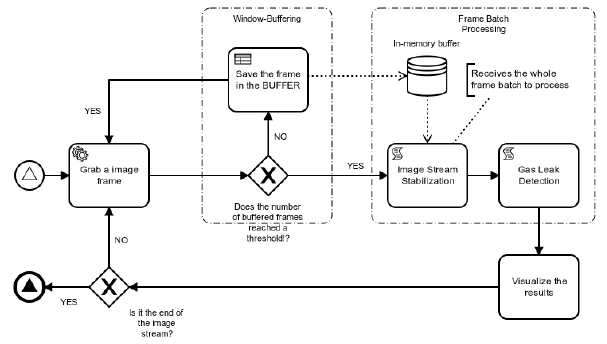
Figure 2. The abstract process flow of the proposed